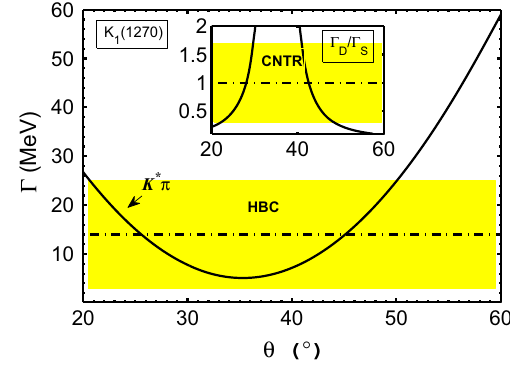
Fig. 2 θ 1 P dependence of the K 1 ( 1270 ) → K ∗ π decay width